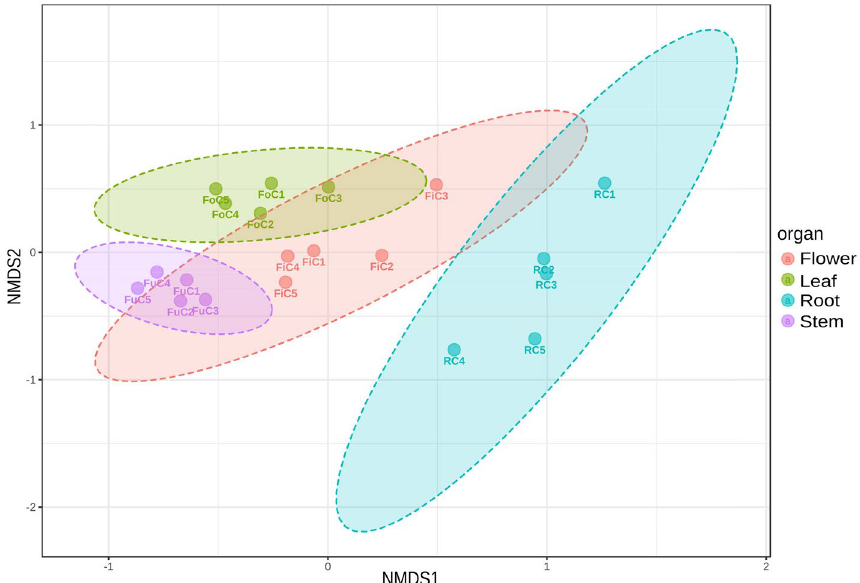
Figure 1. Beta-diversity of the fungal assemblages associated with the different plant organs. The beta-diversity among the different organs was estimated by a NMDS analysis based on Bray–Curtis dissimilarities, with the following parameters: taxonomic level: feature, statistical method: PERMANOVA, experimental factor: organ. Fi = Flowers, Fo = Leaves, Fu = Stems, R = Roots. C1-C5: samples.